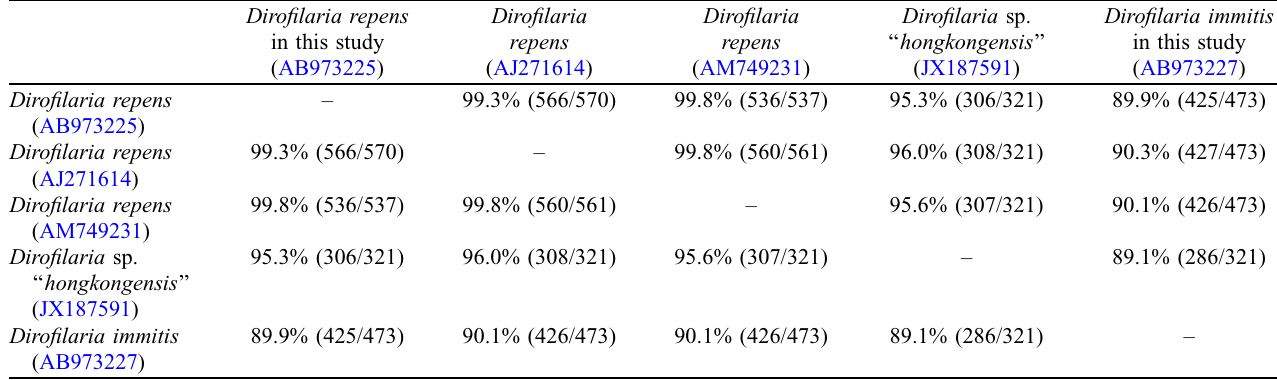
Table 3. Similarities (%) in the COI gene sequences among Dirofilaria repens and Dirofilaria immitis